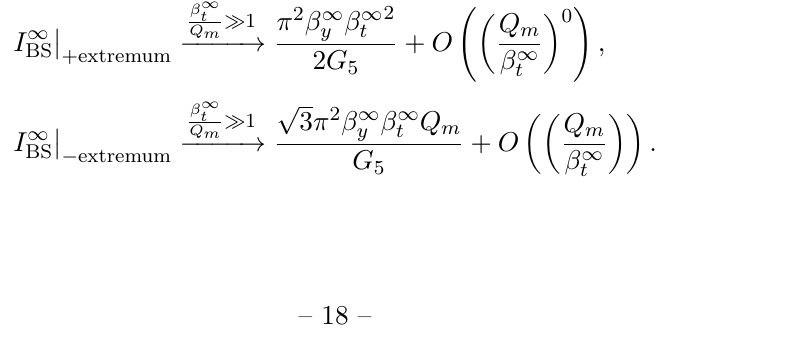
Figure 2 . Phase space of locally-stable magnetic black